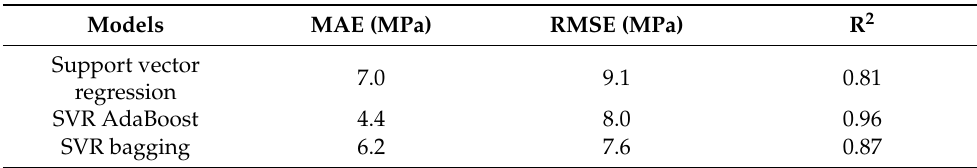
Table 2. Statistical analysis of the approaches used.